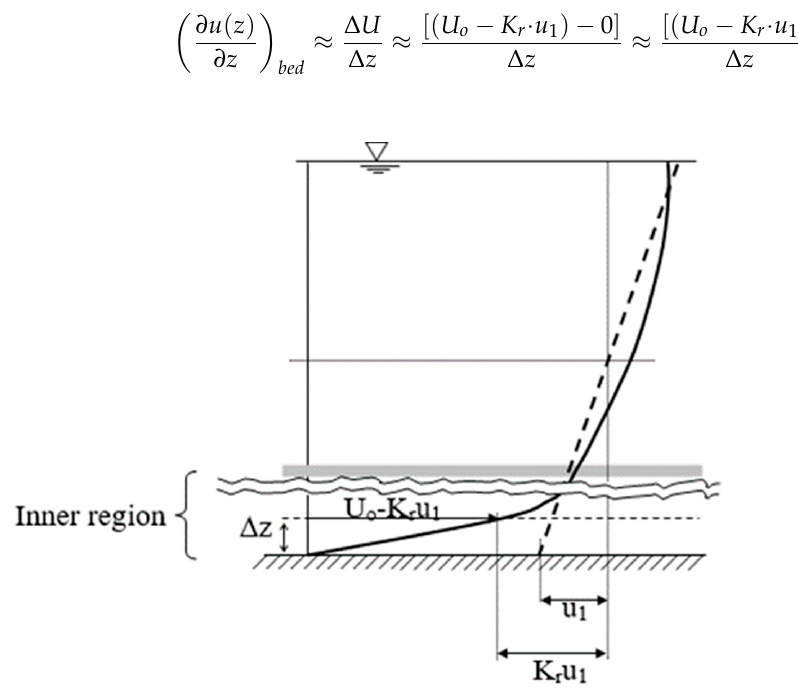
Figure 4. Scheme of the near-bed velocity and the distribution of the actual velocity (solid line) and the equivalent linear velocity (dashed line) in the case of non-uniform flow.